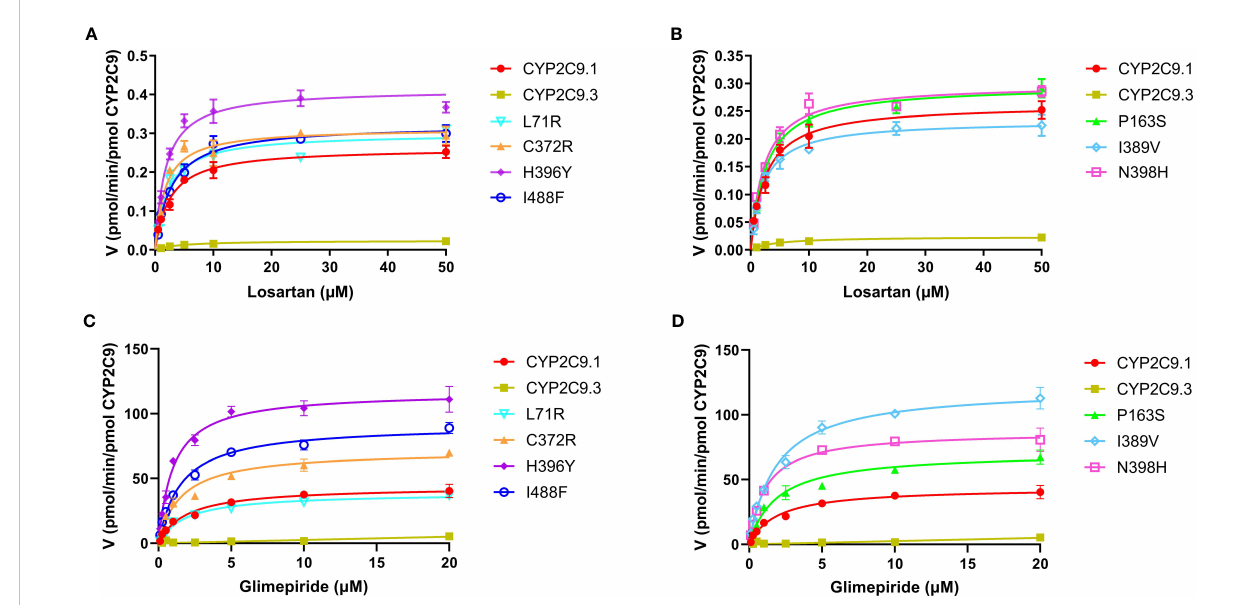
FIGURE 4 Michaelis-Menten curves of the enzymatic activities of expressed CYP2C9 variants toward losartan (A, B) and glimepiride (C, D) . Each point represents the mean ± S.D. of 3 separate experiments.